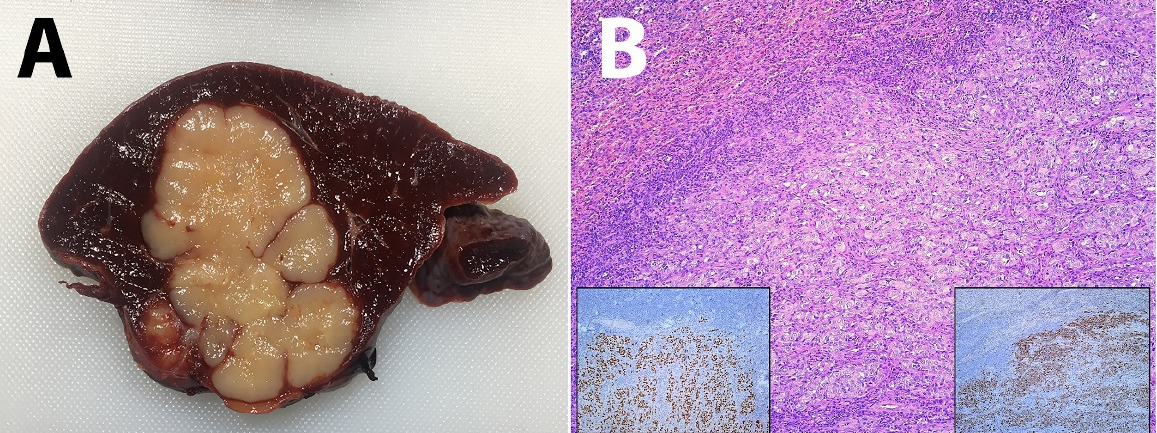
Figure 2. Macroscopic appearance of metastatic change on the cross-section of the spleen ( A ). Poorly differentiated carcinoma, showing on immunohistochemical examination strong nuclear immuno- expression of TTF-1 and cytoplasmic immunostaining of napsin A ( B ).